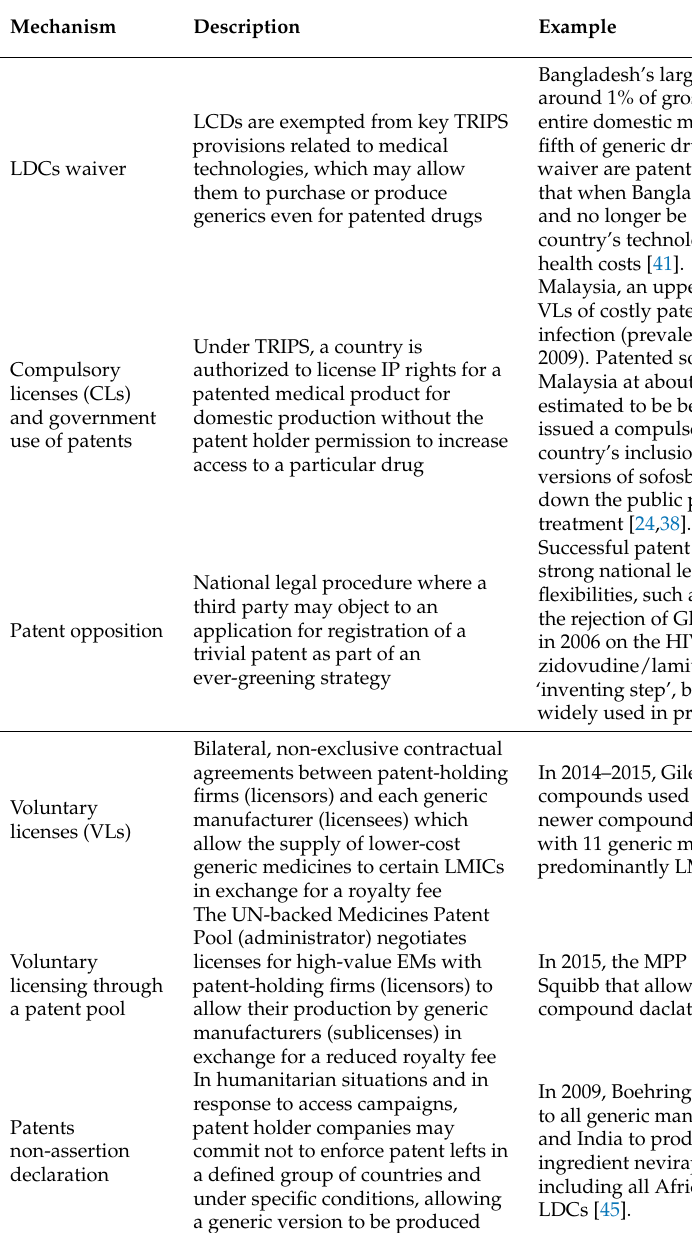
Table 1. Key TRIPS flexibilities and voluntary IP practices to promote generics entry of essential medicines in